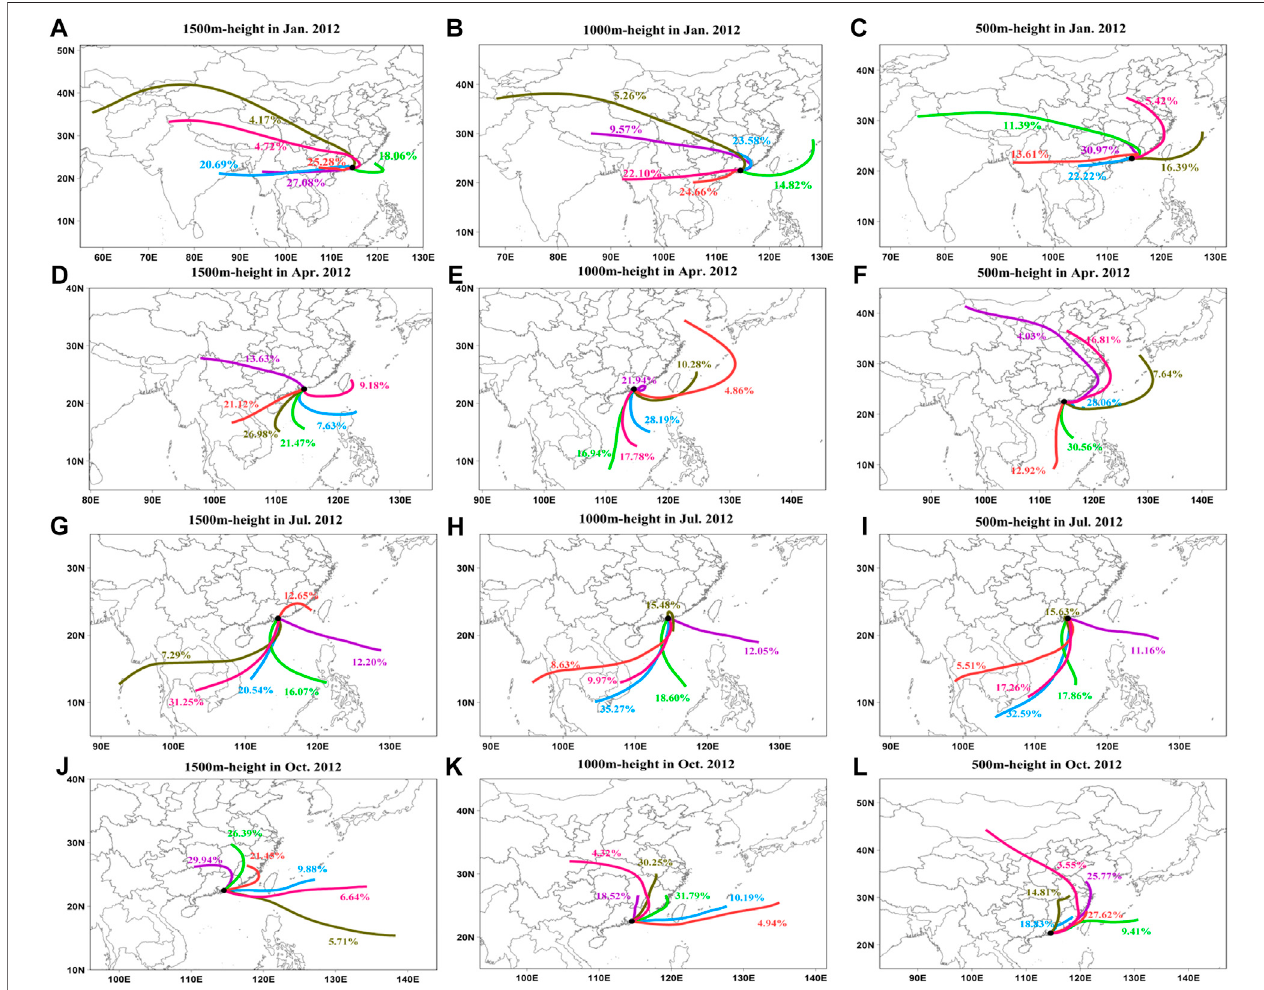
FIGURE 9 | Clustered 72-h backward trajectories of air mass ending at 1500 m (left panel), 1000 m (middle panel), and 500 m (right panel) in January (A – C) , April (D – F) , July (G – I) , and October (J – L) 2012, calculated by the Hybrid Single-Particle Lagrangian Trajectory (HYSPLIT) model.